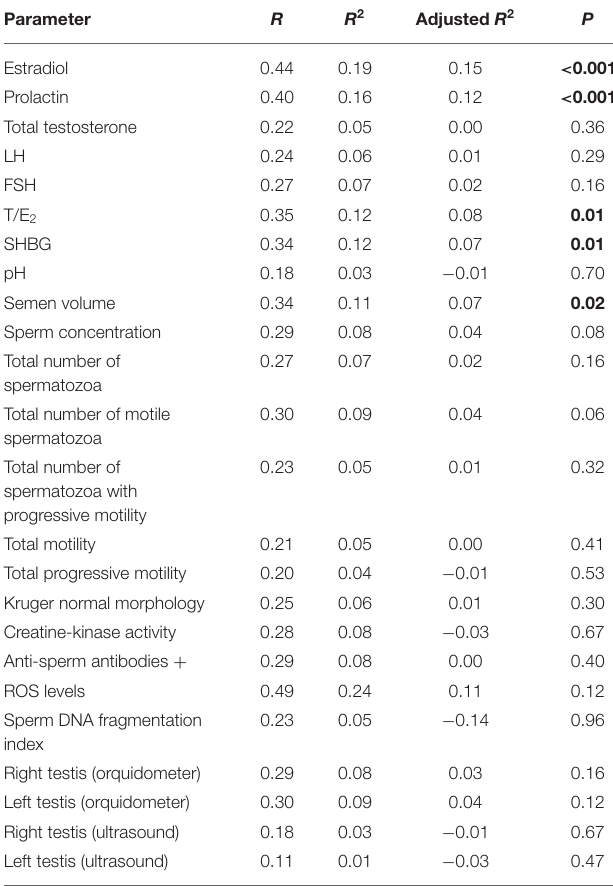
TABLE 2 | Basic semen abnormalities found in the infertile cohort ( n = 153), 2009–2017. Seminal parameter